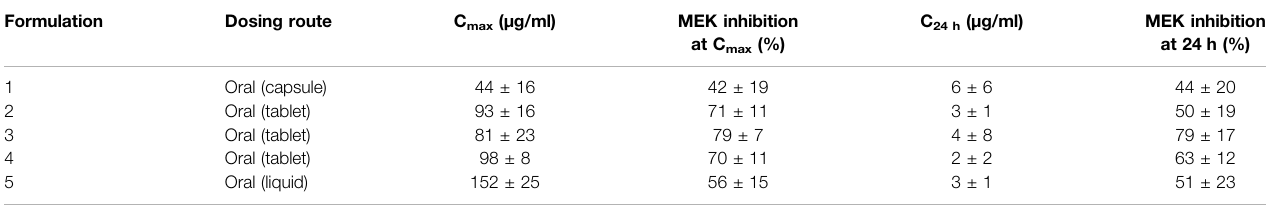
TABLE 4 | Association of PK and PD parameters of zapnometinib formulations in dogs.